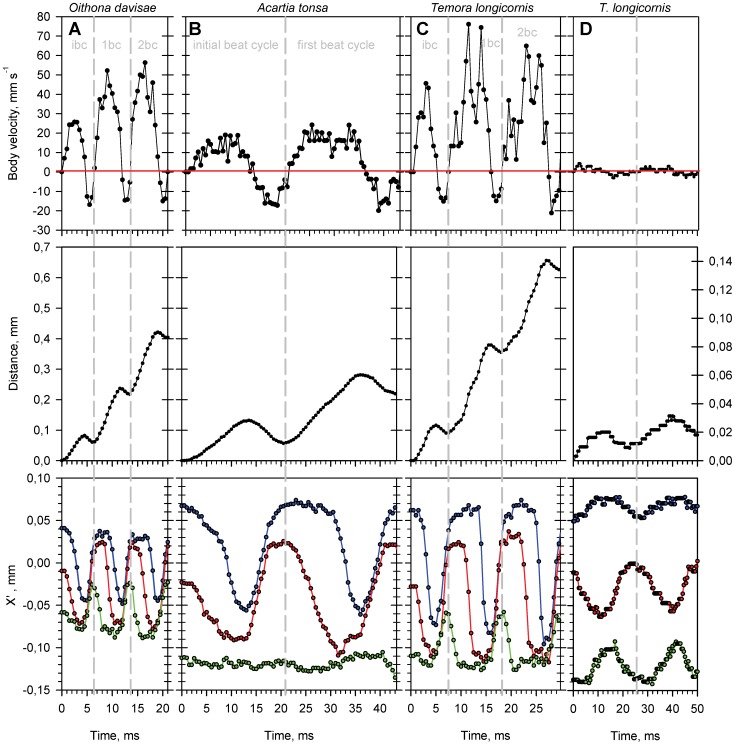
Characteristics of spontaneous relocation jumps and of swimming.Beat cycles analyzed for an individual nauplius of: A) Oithona davisae (body length = 0.154 mm), B) Acartia tonsa (body length = 0.154 mm), C) Temora longicornis (body length = 0.168 mm), and D) T. longicornis swimming (body length = 0.290 mm). Body velocity (upper panels), total distance travelled (middle panels) and the position of appendages relative to the tip of the nauplius head (lower panels), all as function of time. Positions of the tips of antennules, antennae and mandibles relative to the tip of the body are shown in blue, red and green, respectively. Grey vertical dashed lines indicate the end/beginning of a beat cycle, ibc: initial beat cycle, 1bc: first beat cycle, 2bc: second beat cycle.